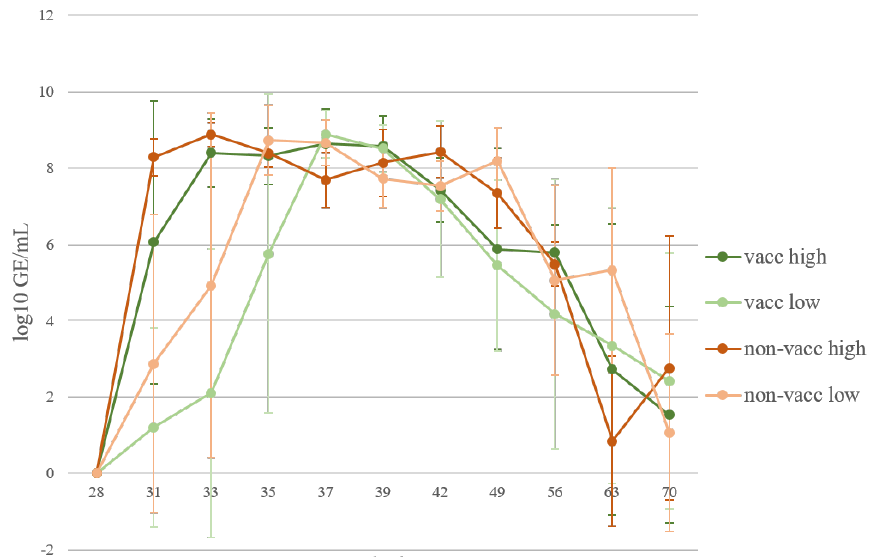
Figure 6. Viral load in serum. Mean and standard deviation of qRT-PCR results from serum samples (log 10 GE/mL) of each infected group (vacc high: vaccinated, high dose [10 5 TCID 50 /dose] infected; vacc low: vaccinated, low dose [10 3 TCID 50 /dose] infected; non-vacc high: non-vaccinated, high dose infected; non-vacc low: non-vaccinated, low dose infected) at different time points after infection (study days).